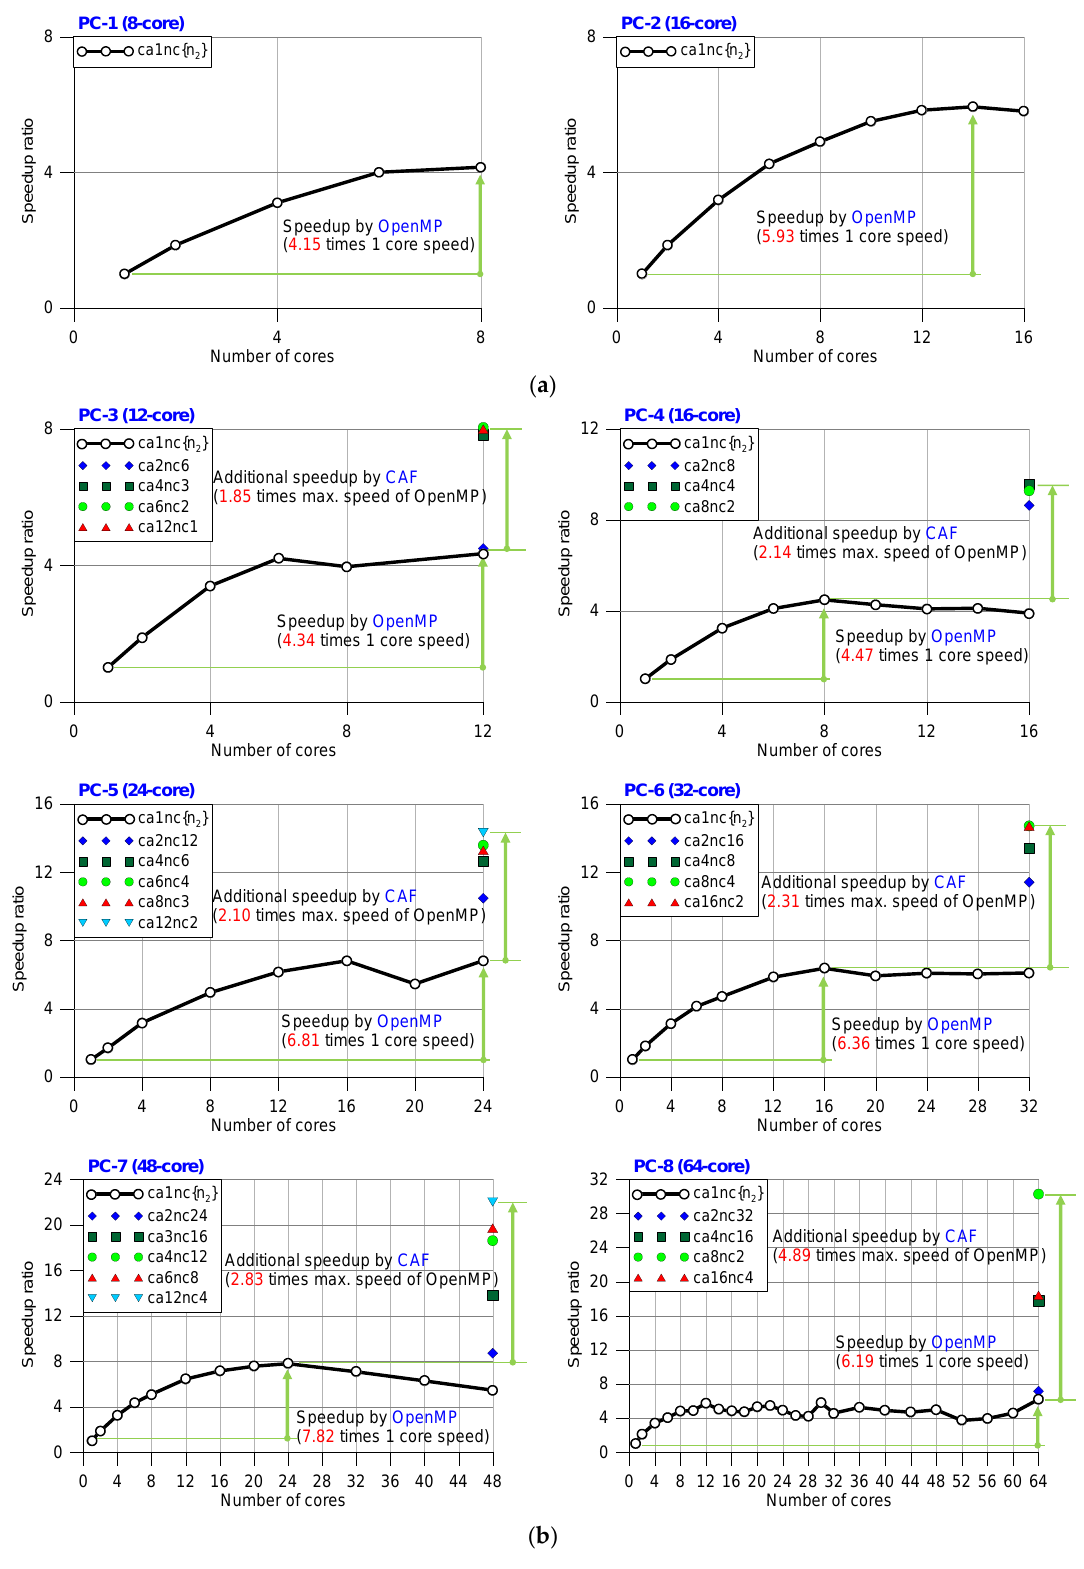
Figure 7. Speedup ratios of OpenMP and OpenMP+CAF for the deep foundation example using various multi-core computer systems (abbreviation: ca{ 𝑛 1 }nc{ 𝑛 2 }; 𝑛 1 = number of coarrays; 𝑛 2 = number of cores/image): ( a ) Single-CPU computer systems; ( b ) Dual-CPU computer systems.